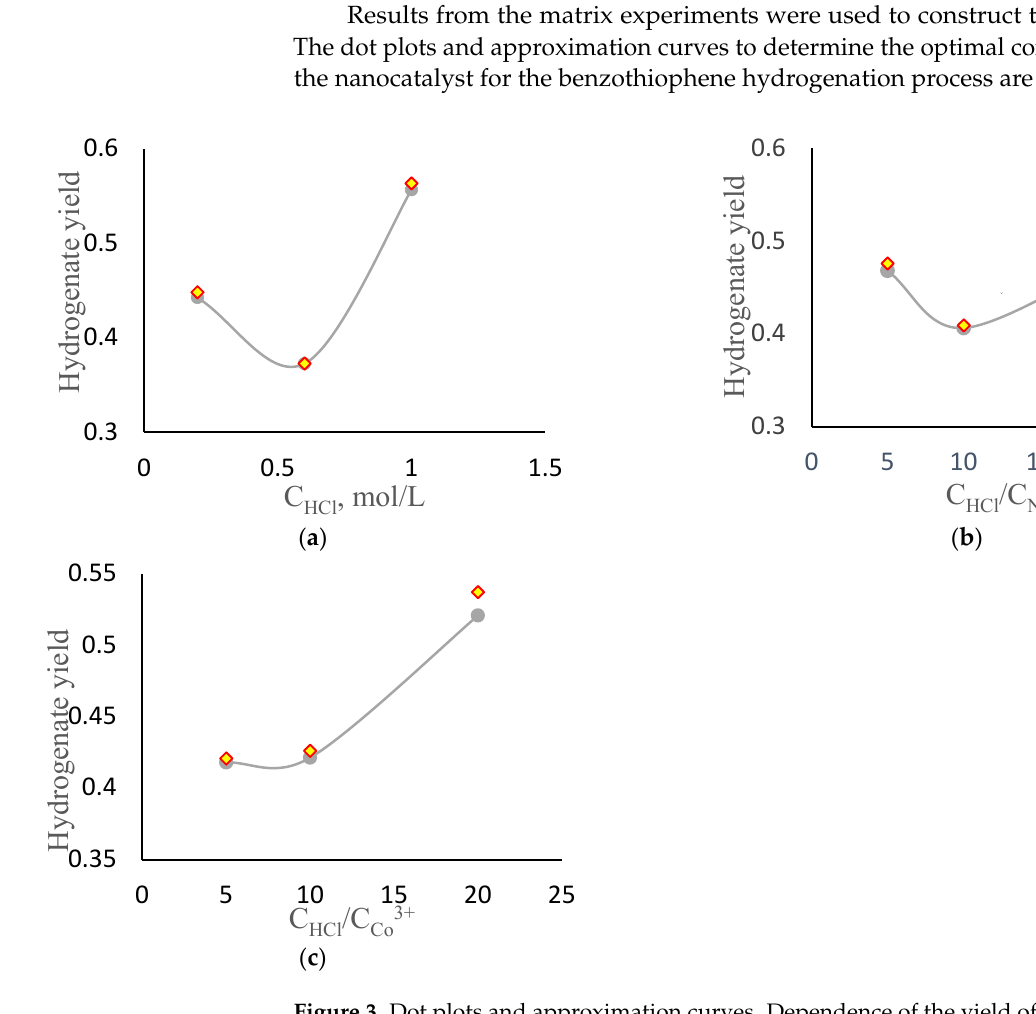
Figure 3. Dot plots and approximation curves. Dependence of the yield of benzothiophene hydro- genation products on: ( a )—HCl concentration, mol/L; ( b ) is the ratio of HCl concentration to nickel concentration; ( c )—ratio of HCl concentration to cobalt